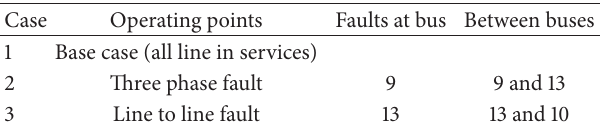
Table 1: System operating conditions considered in damping con- troller design.